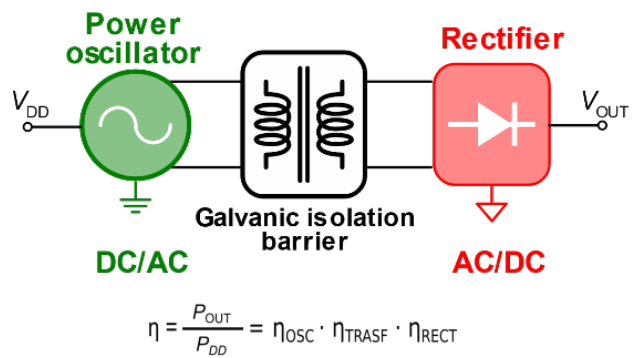
Figure 2. Galvanically isolated DC-DC converter scheme and power efficiency expression, η .